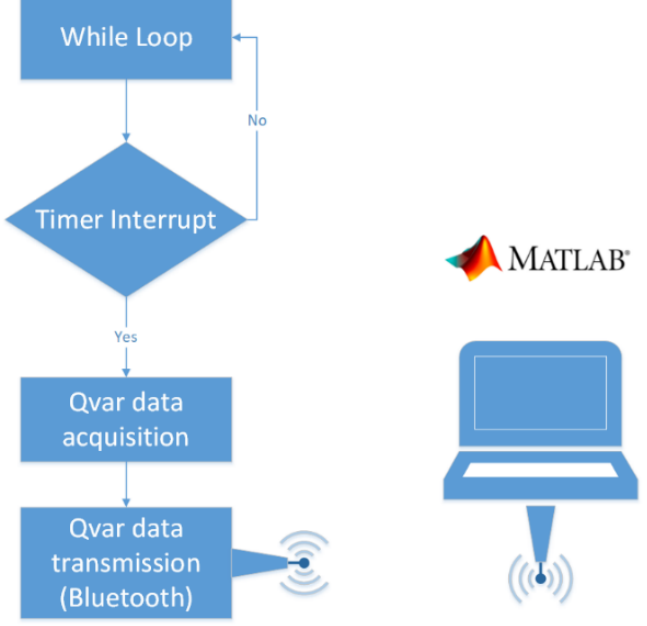
Figure 10. Block diagram of the proposed firmware. The overall system clock is 3 MHz and the interrupt clock is 240 Hz.